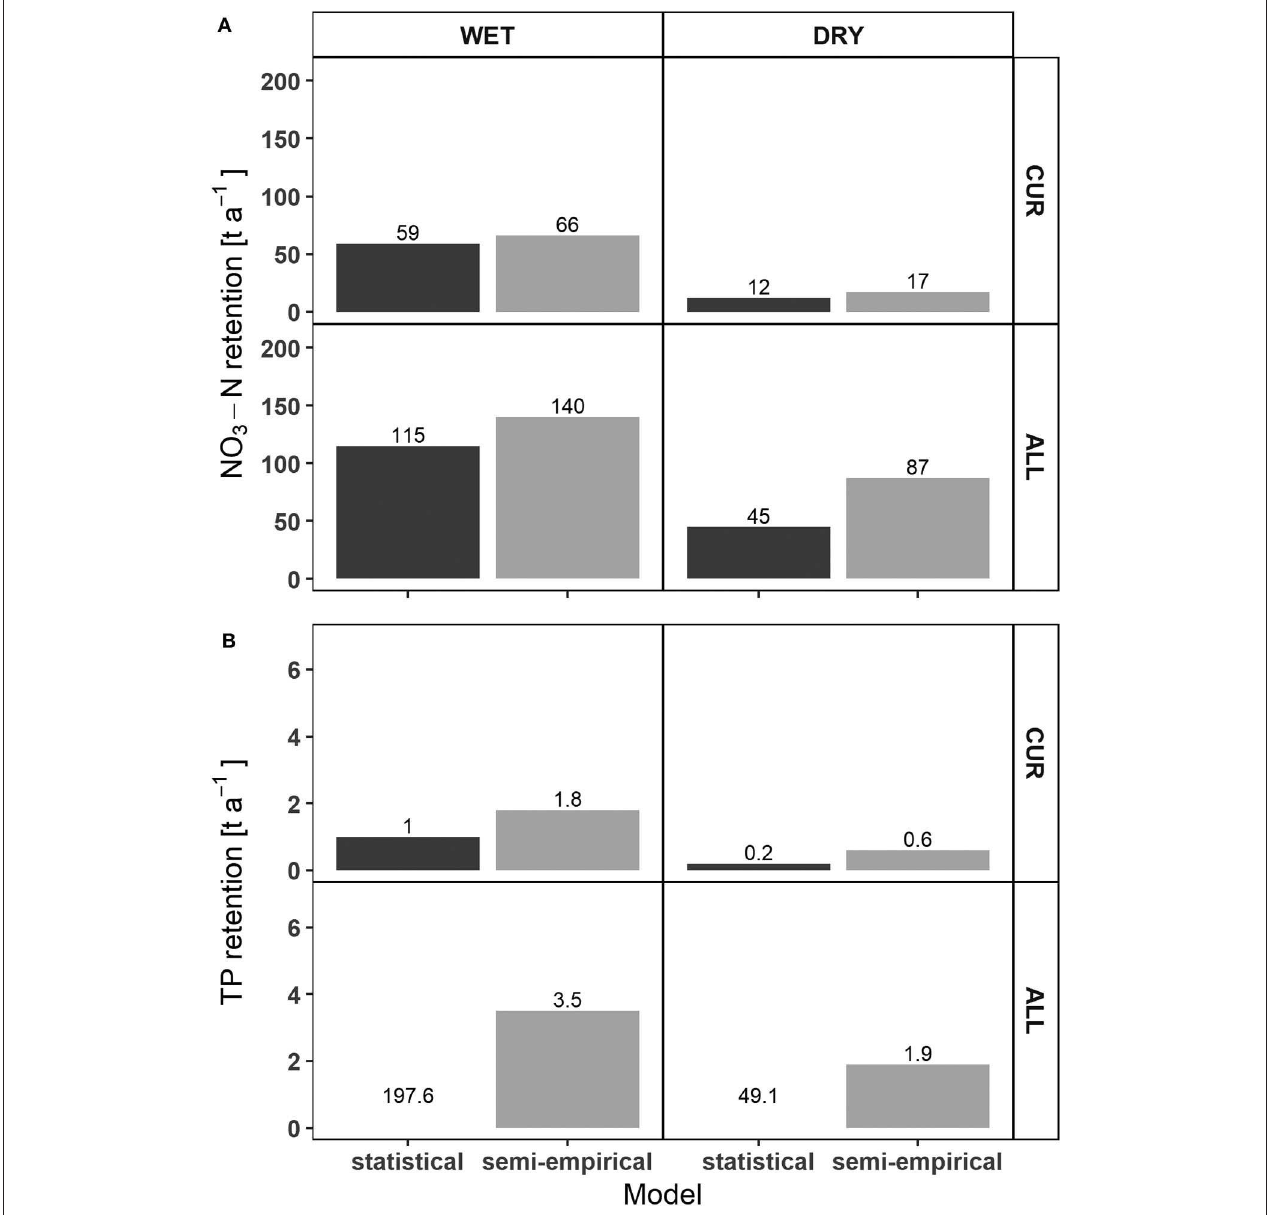
FIGURE 5 | Comparison of absolute NO 3 -N (A) and TP (B) retention in the national park between statistical and semi-empirical models before and after restoration. For reasons of clarity, no bars for TP retention in the ALL scenario of the statistical model are